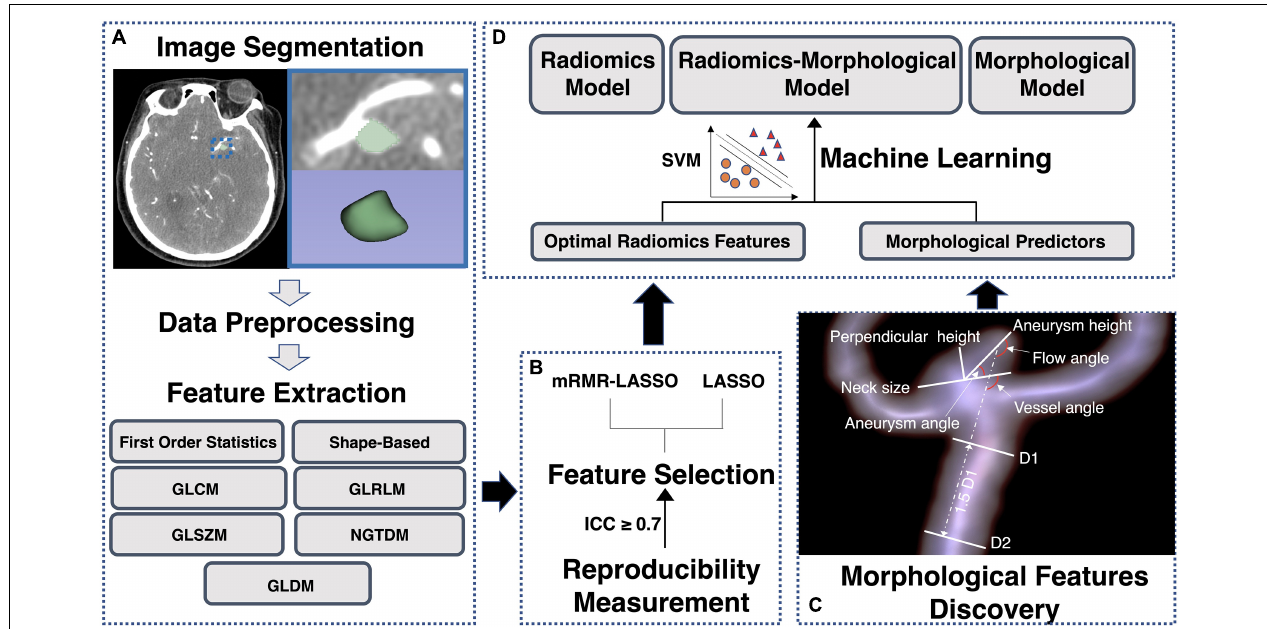
FIGURE 1 | A flowchart of radiomics analysis and radiomics-clinical model construction. (A) The process of regions of interest (ROIs) segmentation; (B) the process of optimal radiomics features detection; (C) the process of morphological predictors discovery; and (D) the process of machine learning models development and validation. GLCM, gray level co-occurrence matrix; GLDM, gray level dependence matrix; GLRLM, grey level run-length matrix; GLSZM, gray level size zone matrix; NGTDM, neighboring gray tone difference matrix; SVM, support vector